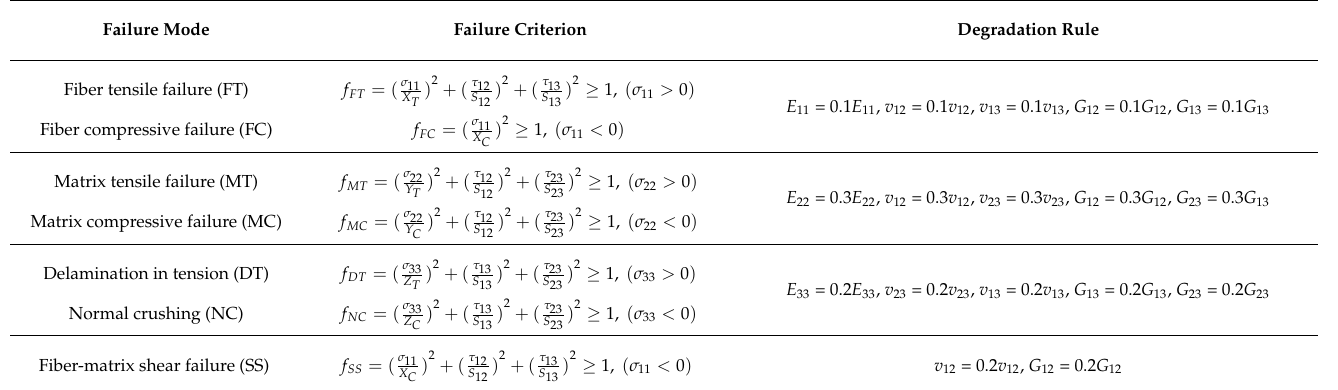
Table 4. Failure criteria and degradation rules for T700/QY9611 composite materials.